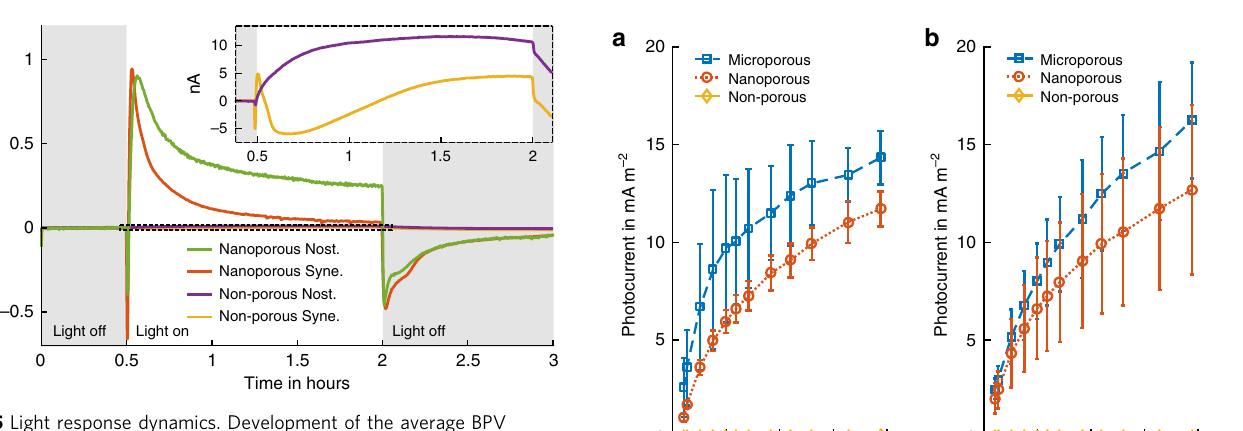
Fig. 5 Light response dynamics. Development of the average BPV photocurrent over time at a photon fl ux density of 512 µ mol m − 2 s − 1 , for non-porous and nanoporous fi lm electrodes and both Nostoc and Synechocystis